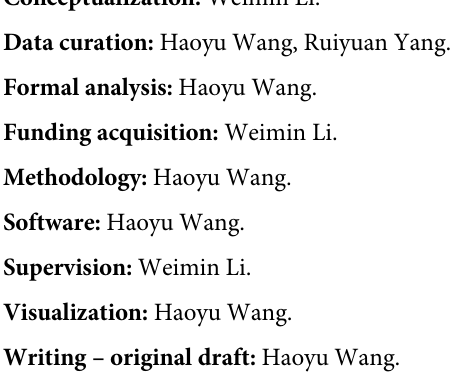
S1 Table. Quality assessment for each individual study